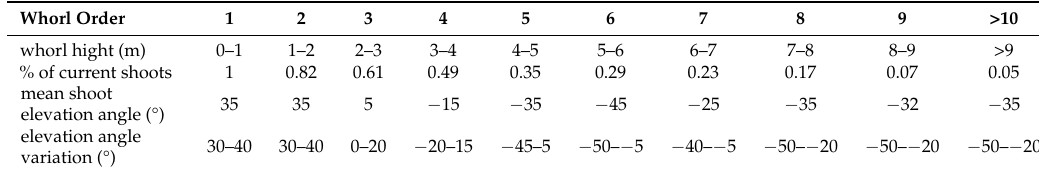
Figure 4. Measured optical properties of Norway spruce needles and other stand elements used for parameterization of DART simulations: ( a ) optical properties for the top, middle, and bottom crown levels applied in the case of basic tree representation; ( b ) optical properties of two needle age categories (current-year and older needles) that were used for the 3D tree representation reconstructed from TLS point clouds; and ( c ) optical properties of spruce bark and forest floor. Table 1. Field data on spatial and angular distribution of Norway spruce shoots (destructive sampling of 20 trees) extracted from Barták [54,55]. Percentage of current-year shoots, mean shoot elevation angle, and that angle’s variation in the vertical crown levels associated with branch whorls are counted from top to